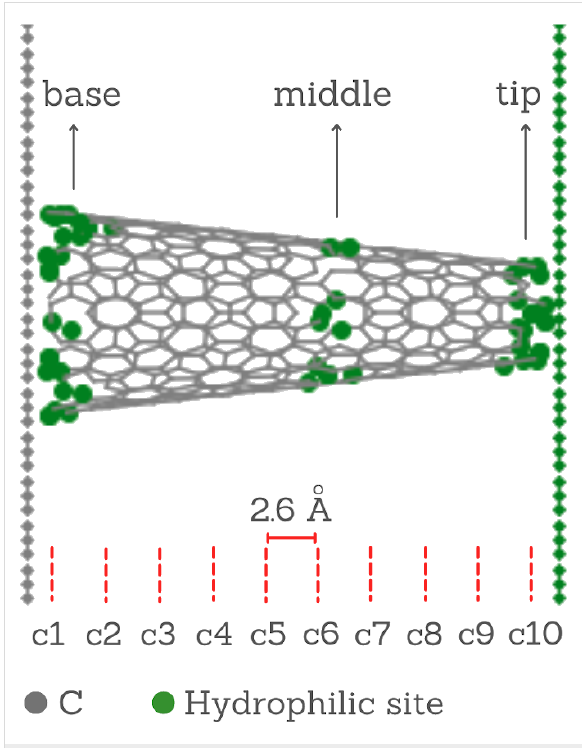
Figure 3: Carbon nanocone with 26 Å length, 8.2 Å tip diameter, and 17 Å of base diameter. Hydrophilic rings are present at the base, the tip, and the middle of the